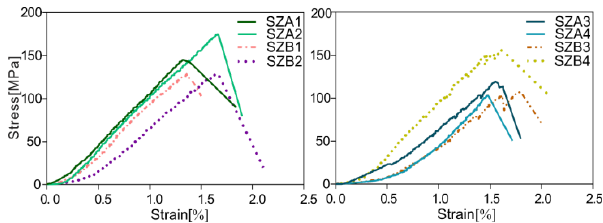
Figure 5. Stress-stain curves of Longmaxi shale specimens SZA1-4 and SZB1-4. The uniaxial compressive strength (UCS) and Young’s modulus (E) test (Table 1) show that, for the SZA specimens with 0° orientation, the UCS ranges from 103.52 to 174.63 MPa (with an average at 135.75 MPa), and E ranges from 10.09 to 12.93 GPa (with an average at 11.91 GPa). The UCS of SZB with 90° orientation is in the range of 107.16–155.76 MPa (with an average at 134.67 MPa), and E is between 8.77 and 11.91 GPa (with an average at 10.70 GPa). The average values of the UCS and E for specimens at 0° orientation are both slightly higher than the average values obtained at 90° orientation. In addition, the UCS values at 0° and 90° orientation are all characterized by large variation, but there was little variation among E values, supposedly caused by the heterogeneity of structure and mineral composition. Table 1. Uniaxial compression of Longmaxi shale specimens SZA and SZB.